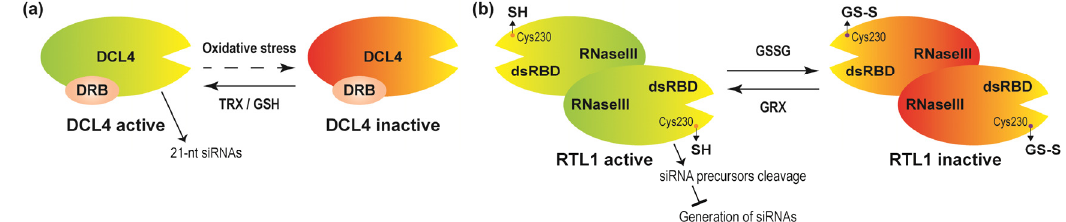
Figure 2. Redox components regulate DCL4 and RTL1 activities. ( a ) Processing of siRNA precursors by DCL4 requires dsRNA-binding protein (DRB), especially DRB4. GSH and TRXs are able to restore DCL4 activity from the inactive state. Activated DCL4 promotes 21 nt siRNA production. ( b ) GSSG / GRXs influence RTL1 activity. RTL1 has RNase III domain and dsRNA binding domains (dsRBD), and acts dimers to perform functions. GSSG treatment results in RTL1 glutathionylation at Cys230 position and inhibits its activity. RTL1 activity is restored by glutaredoxin proteins (GRXs). RTL1 negatively regulates siRNA production prior to DCL–mediated cleavage of the siRNA precursors. The dashed line indicates uncharacterized regulation.